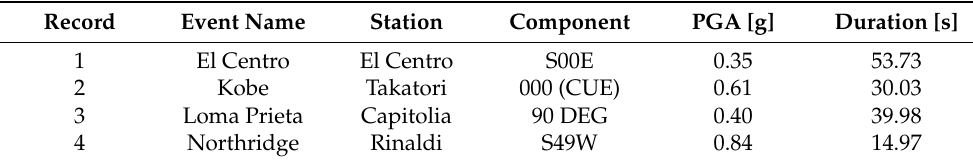
Table 1. Characterization of the benchmark